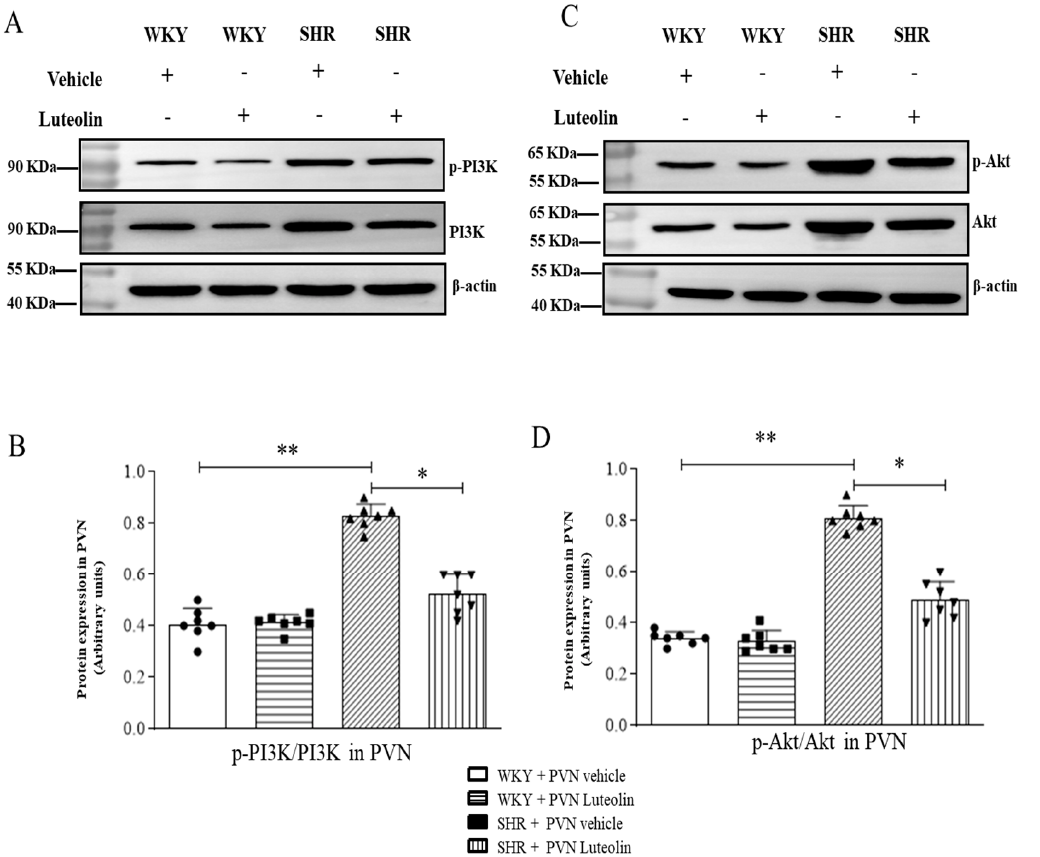
Figure 8. Effects of PVN luteolin on PI3K/Akt signaling pathway in PVN. ( A ) The protein expression levels for p-PI3K were determined by Western blotting. ( B ) Densitometry of protein expression for p-PI3K in the PVN of SHRs and WKY rats, with or without luteolin treatment. ( C ) The protein expression levels of p-Akt were analyzed by Western blotting. ( D ) Statistical analysis of protein expression levels of p-Akt in PVN of SHRs and WKY rats treated with luteolin or aCSF. Values are the mean ± SEM from 7 rats/group. * p < 0.05, ** p < 0.01.